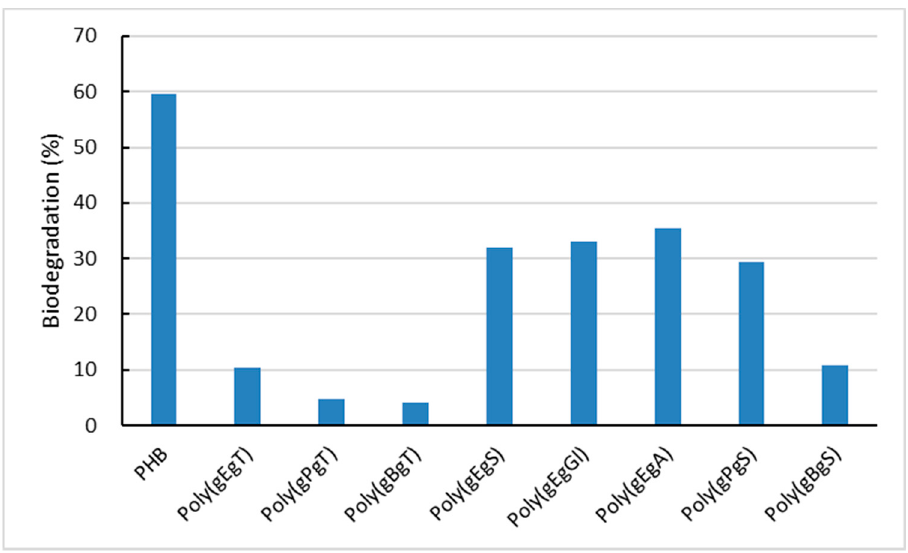
Figure 6. Biodegradation of the poly(ester amide)s in seawater after 30 days.